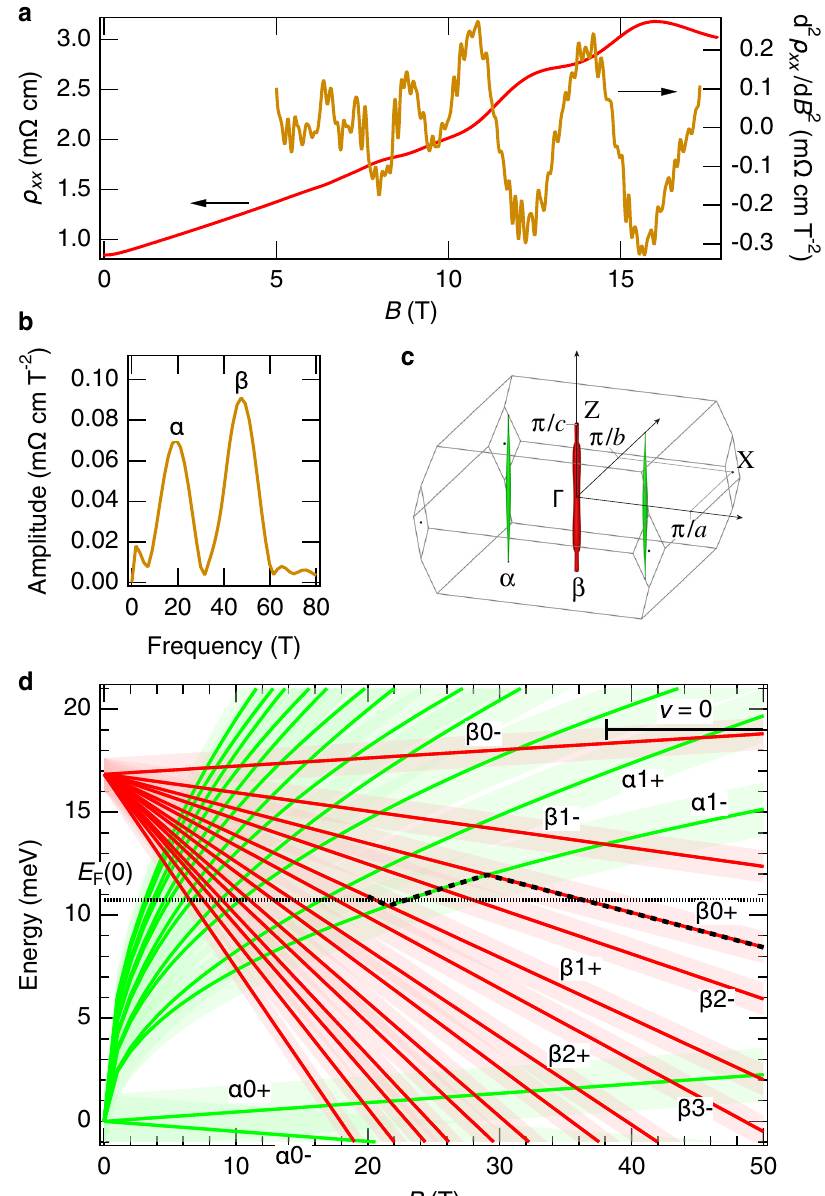
Fig. 1 Shubnikov-de Haas oscillation, Fermi surface, and Landau-level diagram in CaFeAsF. a In-plane resistivity ρ xx as a function of the magnetic fi eld B applied along the c axis, as measured on sample D2 at T = 0.03 K. The corresponding second-derivative curve, d 2 ρ xx /d B 2 , is also shown. b Fourier transform of the curve d 2 ρ xx /d B 2 vs 1/ B . The labels α and β refer to electrons and holes, respectively. c Fermi surface of CaFeAsF 11 . d Landau-level diagram for CaFeAsF calculated from the Fermi-surface parameters in Table 1. The shading around the levels is based on the Landau-level broadening Γ . The black dashed line above B = 20 T shows the fi eld-dependent Fermi level expected from the carrier conservation when level broadening is neglected (see text). Some of the levels are labeled with the carrier type ( α or β ), the Landau- level index (0, 1, etc.), and the spin species ( + or − ). The horizontal bar shown at the upper right indicates the high- fi eld region where ν =